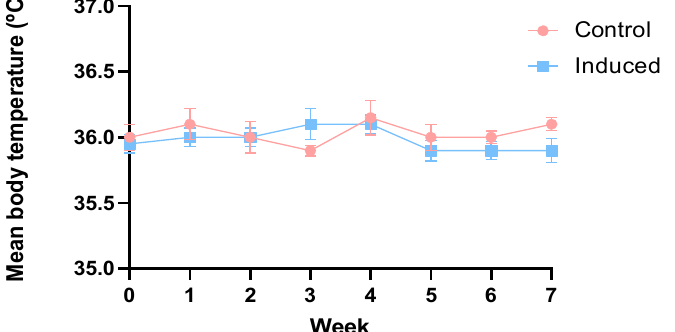
Figure 5. Mean body temperature (°C) recorded weekly per group throughout the protocol. No statistically significant differences were found between the groups ( p > 0.05). The group control (n = 8) was intraperitoneally administrated with 0.1 M citrate buffer, while the induced group (n = 16) was intraperitoneally administrated with STZ diluted in 0.1 M citrate buffer after fructose feeding. Data are presented as mean ± SD.